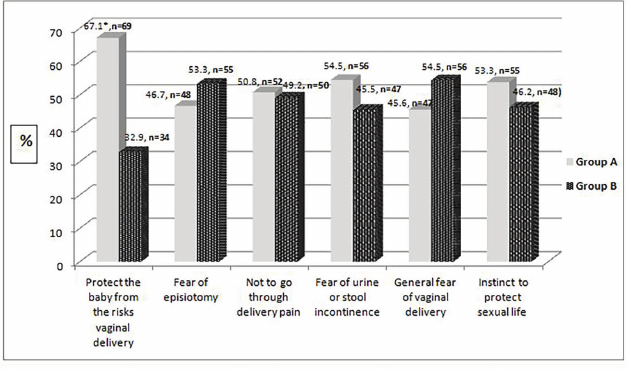
Figure 5 -Distribution of the reasons for preferring cesarean delivery according to working